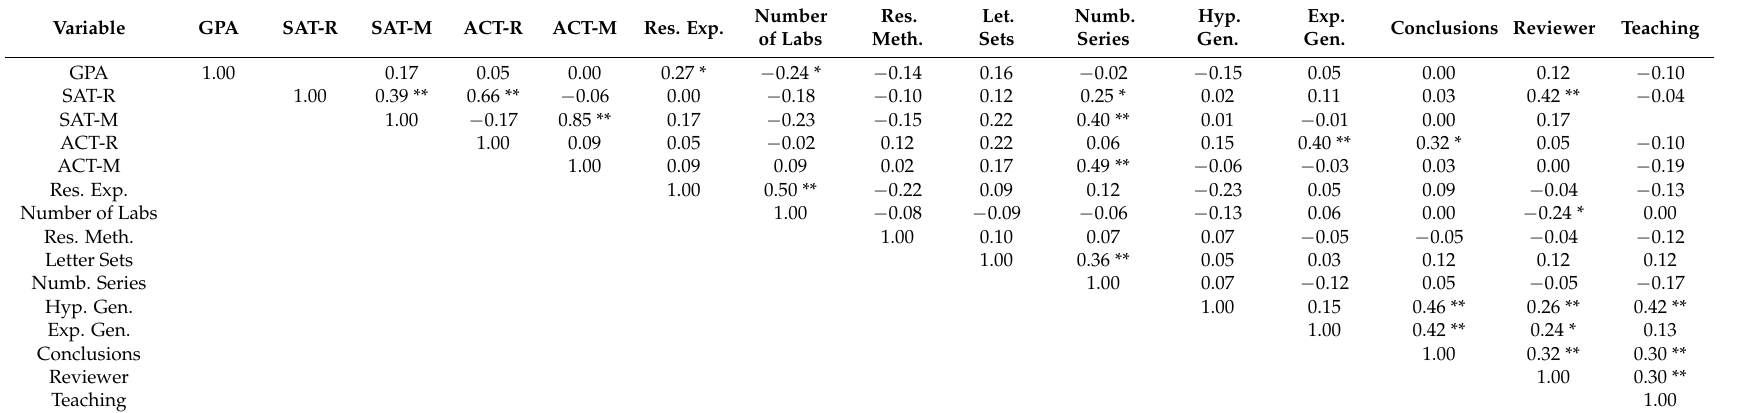
Table 3. Correlations of Selected